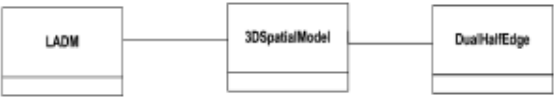
Figure 4. Relationship between LADM, DHE and 3D spatial model